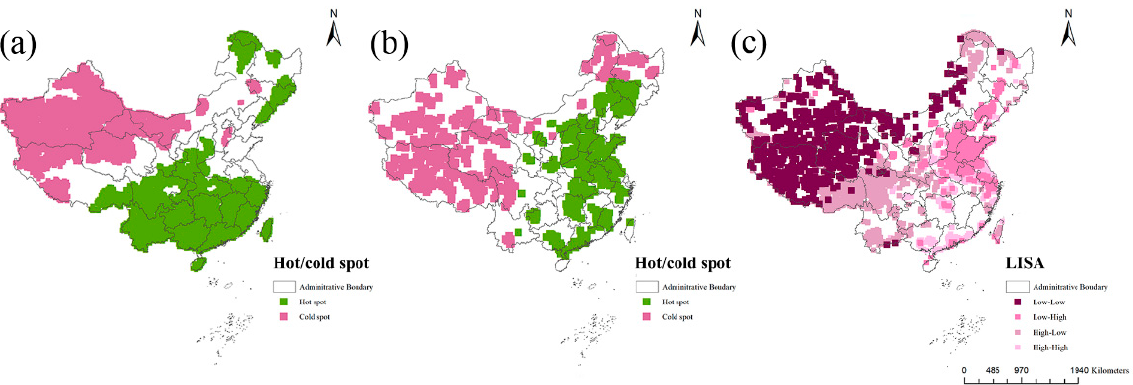
Figure 4. Spatial pattern of the cold spots and hot spots for ecosystem service multifunctionality (ESM) ( a ) and urbanization ( b ), and the spatial. hots pots and aggregation pattern of the ESM and urbanization ( c ) in 2020. “High-High” refers to High ESM-High urbanization; “Low-High” refers to Low ESM-High urbanization; “Low-Low” refers to Low ESM-Low urbanization; “High-Low” refers to High ESM-Low urbanization.